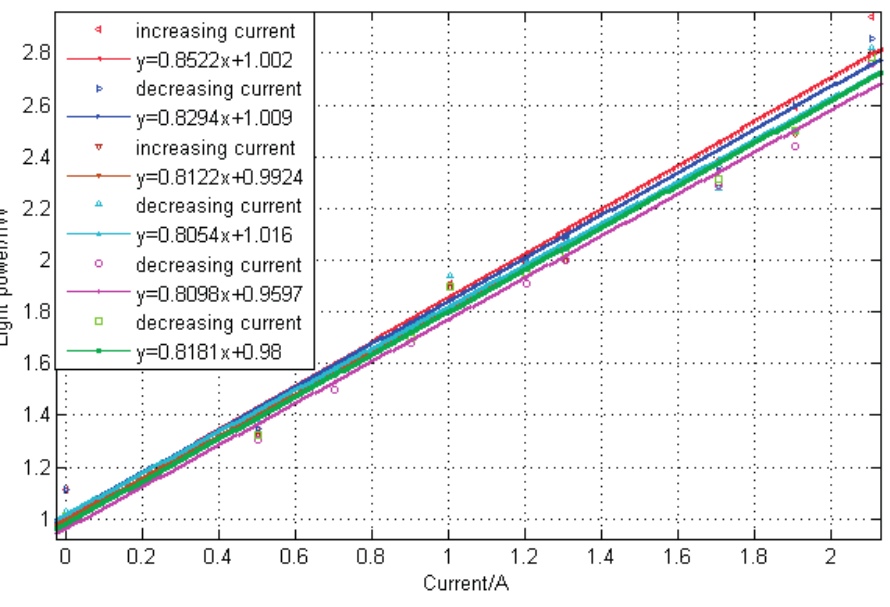
Figure 6. Relationship between light power of the interference with a FBG versus